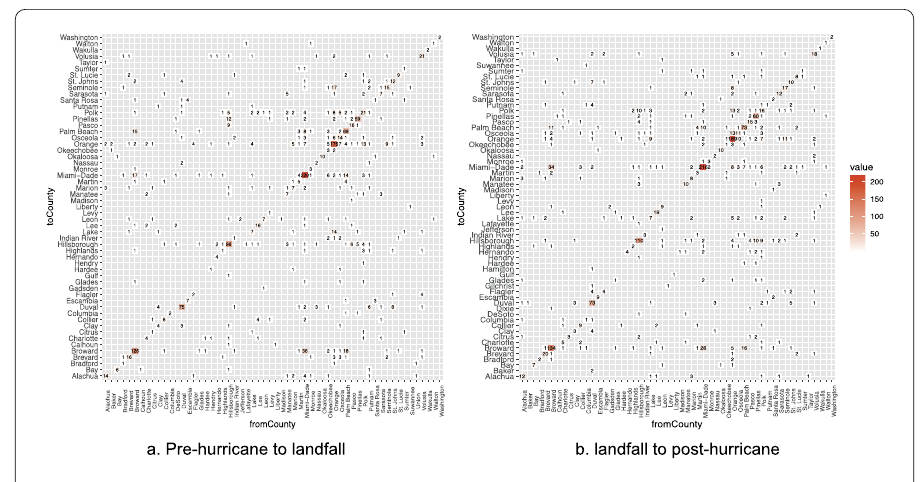
Figure 6 Heat map of evacuation flows across counties in FL